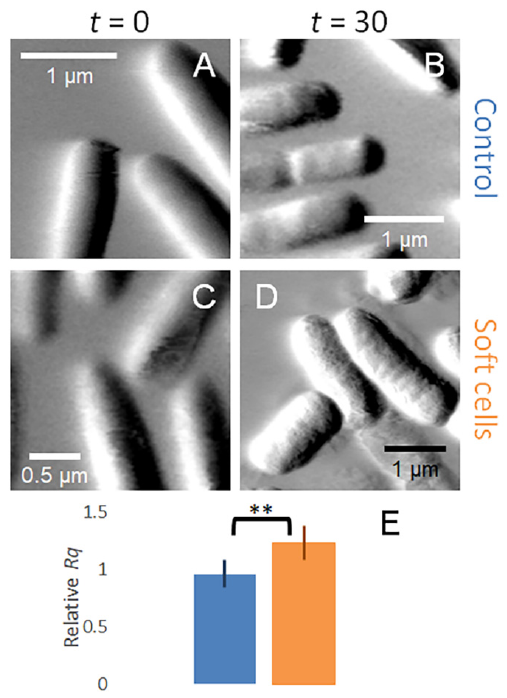
Figure 6. Representative amplitude images of cells in biofilms exposed to DNaseI and dextranase, which remove the EPS. ( A ) Cells in an EPS-stripped biofilm at t = 0 min. ( B ) Cells in an EPS-stripped biofilm at t = 30 min. ( C ) Cells in a MAG2-treated, EPS-stripped biofilm at t = 0 min. ( D ) Cells in a MAG2-treated, EPS-stripped biofilm at t = 30 min. ( E ) The relative Rq for untreated cells (blue) and MAG2-treated cells (orange). The error bars represent standard deviation and the treated cells have a significantly higher Rq than the untreated cells ( p ≤ 0.005). ** p ≤ 0.005.